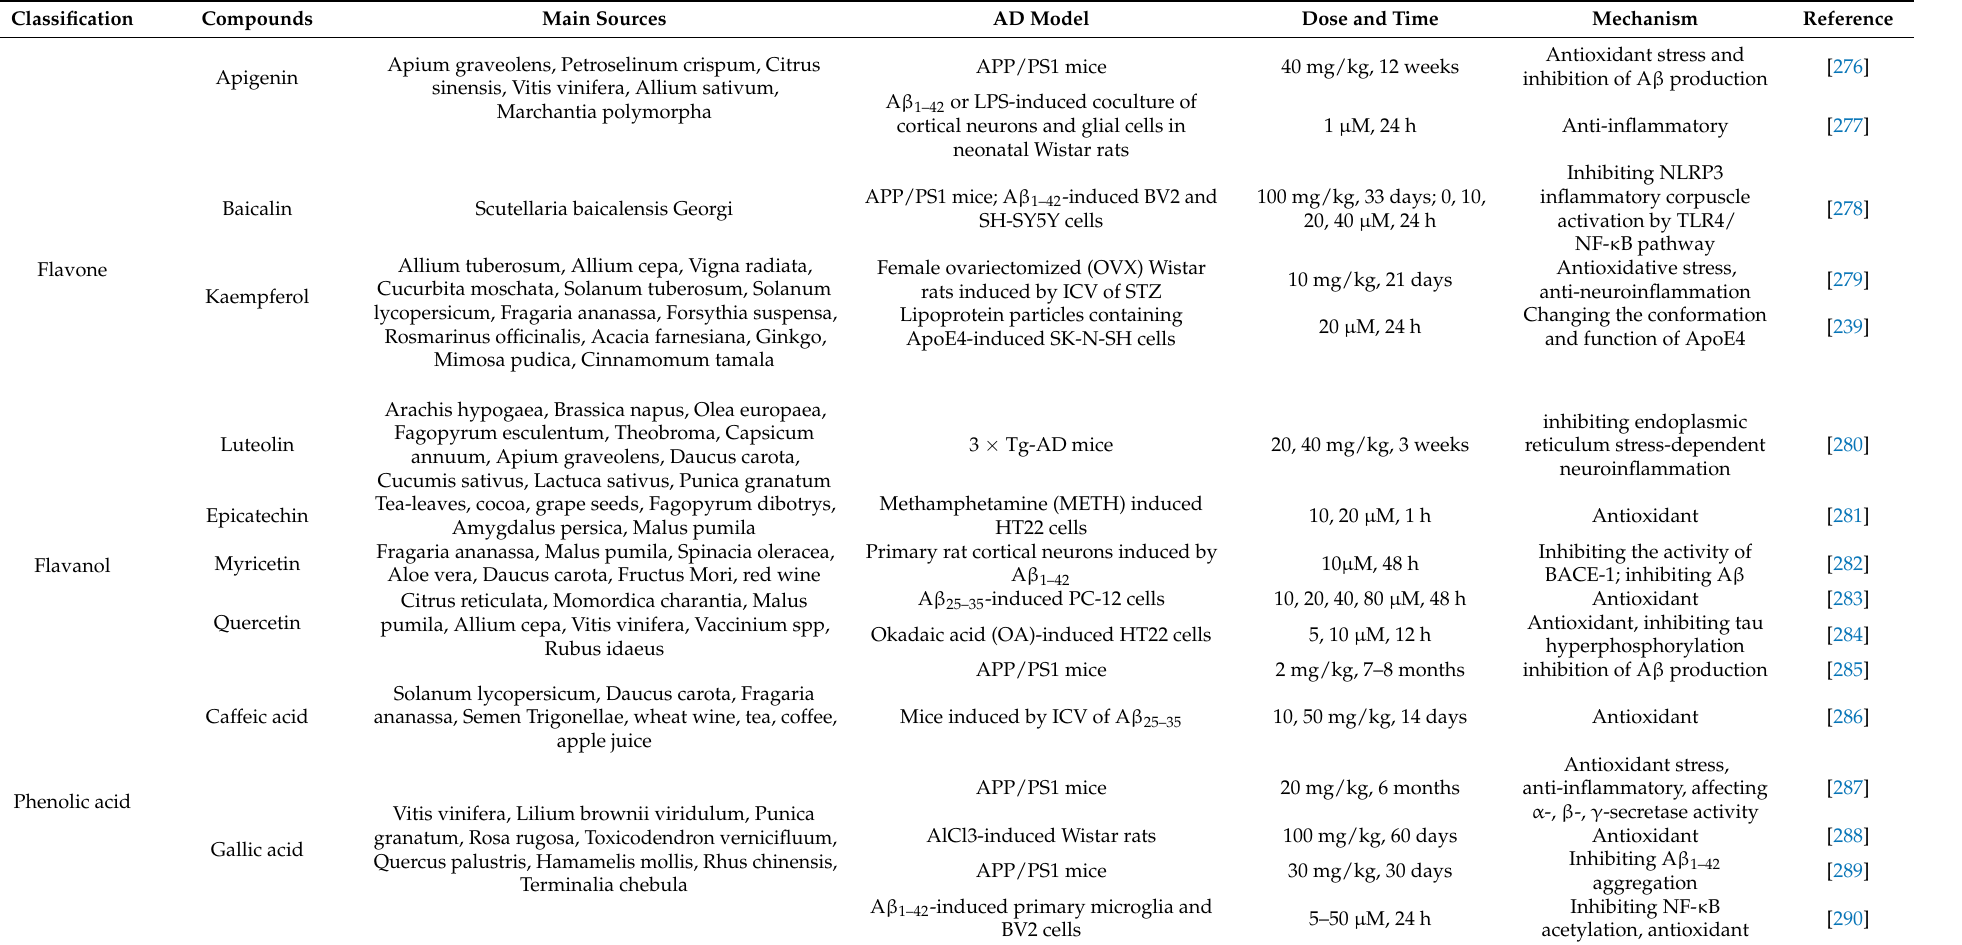
Table 2. Prevention and treatment potential of polyphenols on AD and its